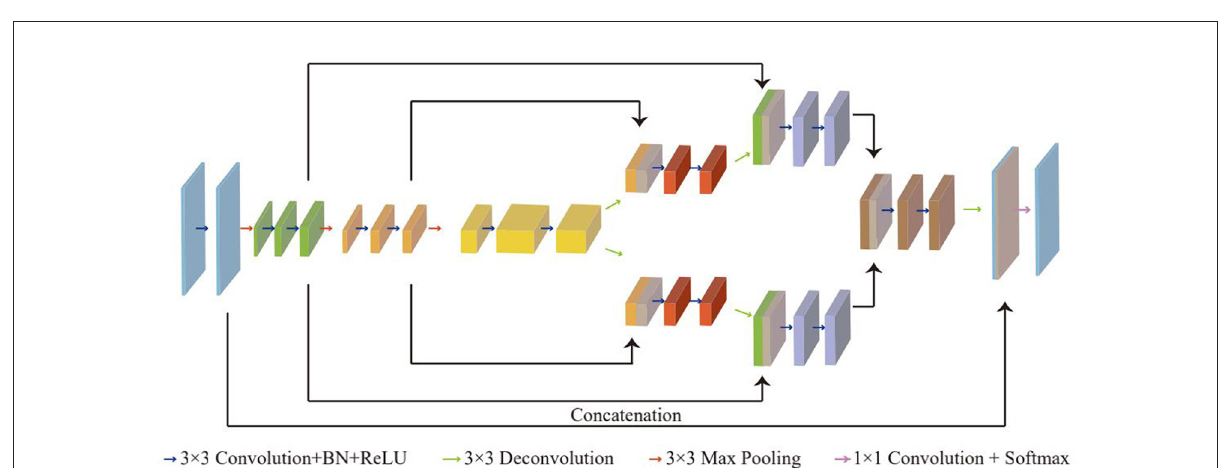
FIGURE2 An illustration of the Mixed-UNet architecture. The coding phase consists of the repeated application of two 3x3 convolutional layers and one 3x3 max pooling operation. Besides, each 3x3 convolutional layer is followed by a BN and a ReLU. Correspondingly, in the decoding phase, each step upsamples the feature map followed by a 3x3 deconvolution to halve the number of feature channels. The feature maps obtained by deconvolution in upsampling are concatenated with the corresponding cropped feature maps in downsampling. The fused feature maps are subjected to the same convolution operation. The final layer that consists of a 1x1 convolutional layer and a softmax layer is used to map each 64 component feature vector to the desired number of classes.